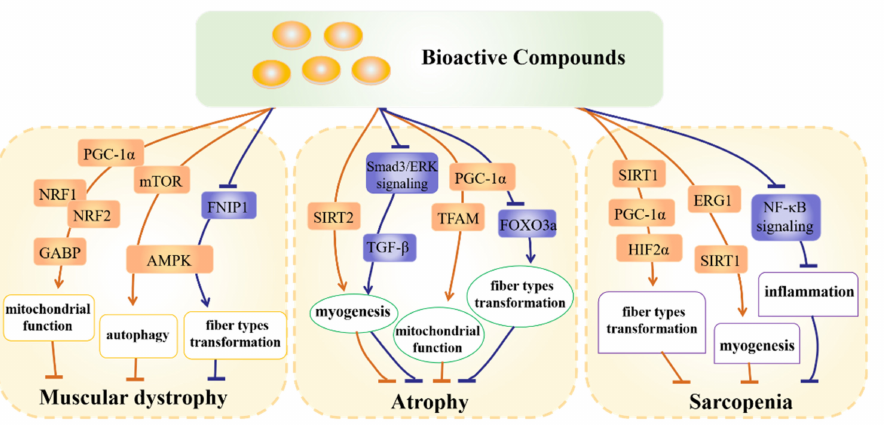
Figure 1. Signaling pathways involved in the regulation of skeletal muscle diseases. → indicates promotion; T indicates